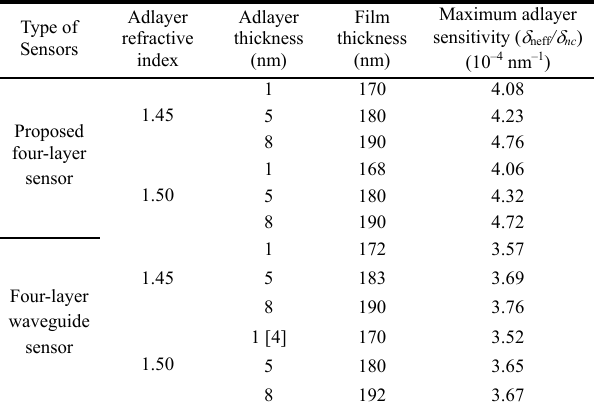
Table 2 Variation of adlayer sensitivity with adlayer and metamaterial film